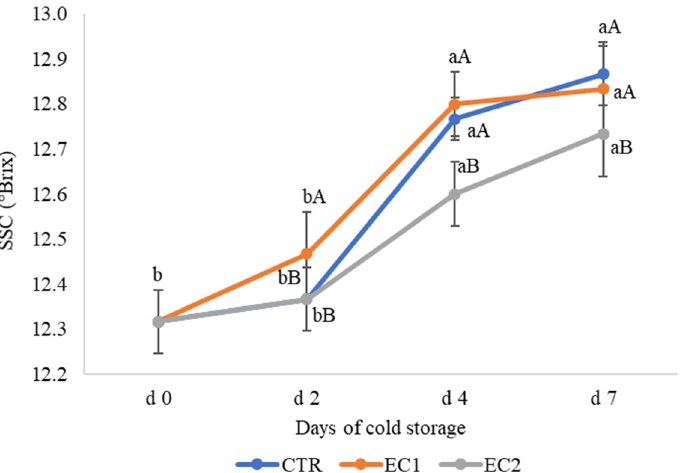
Figure 5. The changes of the soluble solids content (SSC) in °Brix, of treated (EC1 and EC2) and untreated (CTR) pear slices. Data correspond to the means ± standard deviation of three replicates. Means with different letters are significantly different at p ≤ 0.05 using Tukey’s-HSD test. Different lowercase letters denote significant differences ( p < 0.05) between different sampling times for the same treatment. Different capital letters denote significant differences ( p < 0.05) between different treatments for the same sampling time.